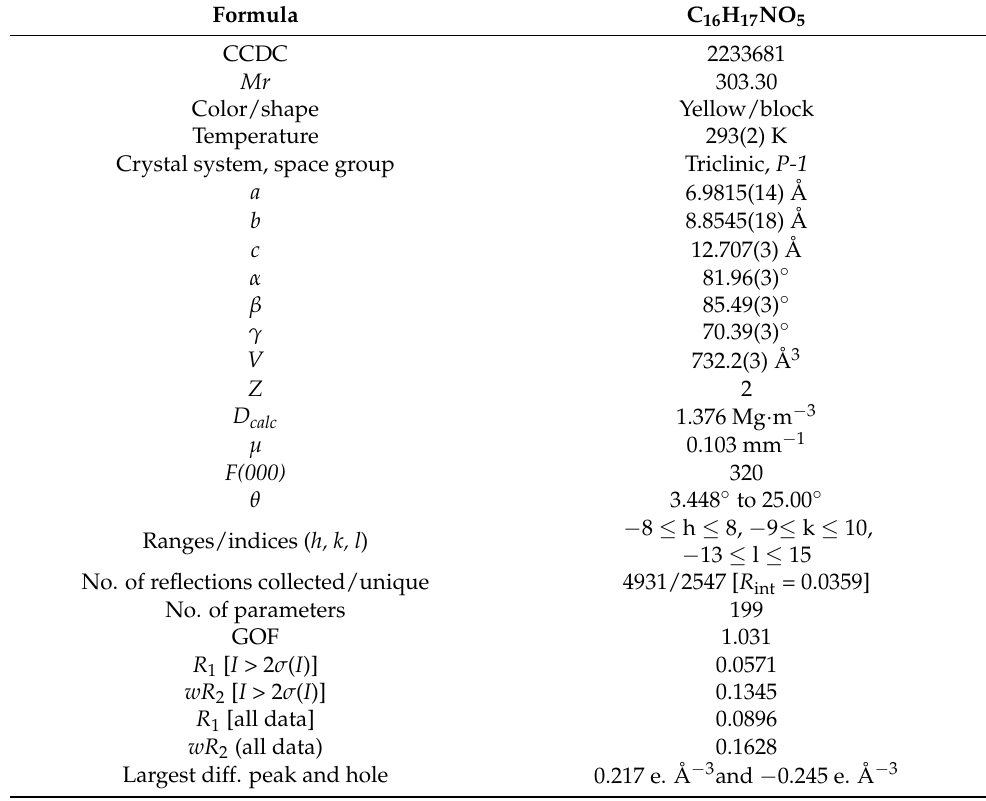
Table 1. Experimental details of HMD